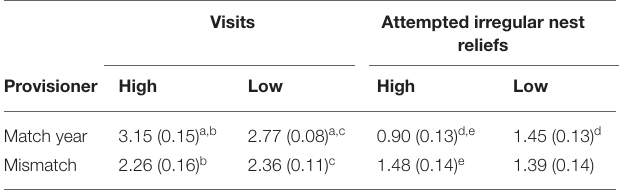
TABLE 2 | Mean (SE) for visits (number per day) and attempted irregular nest reliefs (per day) for the match and mismatch year and for high and low